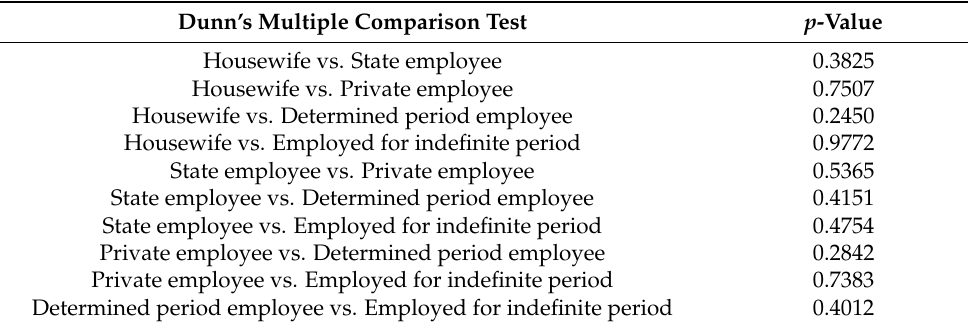
Table 2. p -values for irrationality scale according to social status